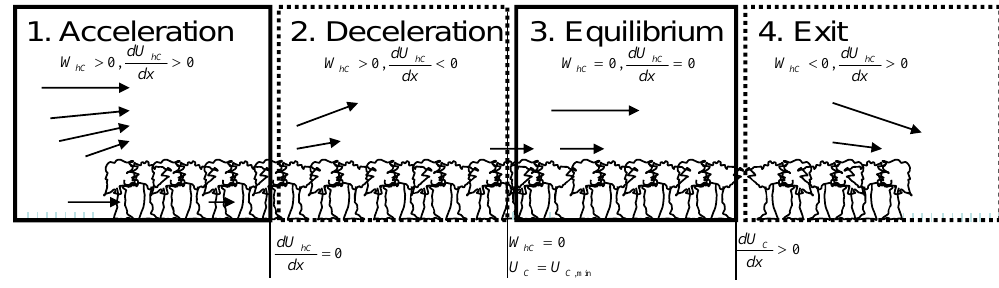
Fig. 1. Sketch of flow downstream of a forest edge.